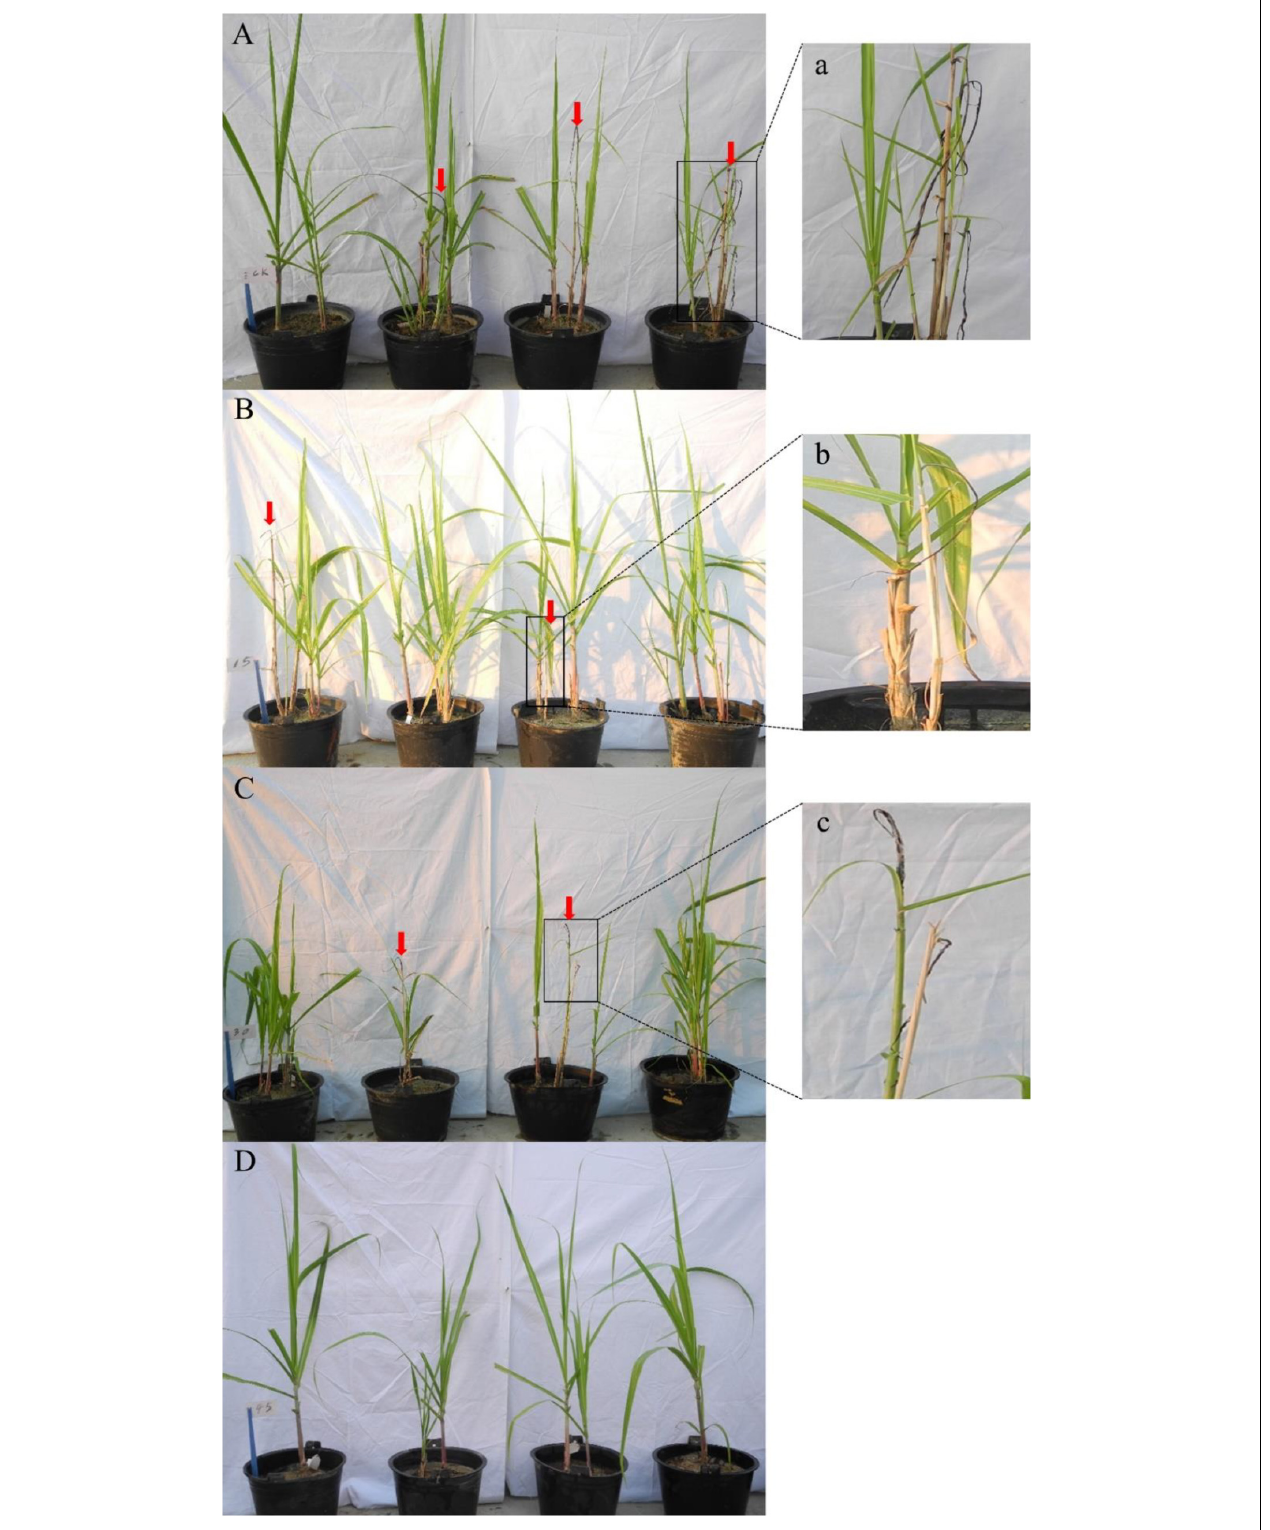
FIGURE 1 | Effect of silicon application on the occurrence of smut in sugarcane cultivar Badila. (A) CK2, no exogenous silicon (ESi) application; (B) Sis15, 15 g ESi barrel − 1 ; (C) Sis30, 30 g ESi barrel − 1 ; (D) Sis45, 45 g ESi barrel − 1 . (a,b,c) : enlarged views of local smut whip for (A–C) . The red arrow refers to smut whips.